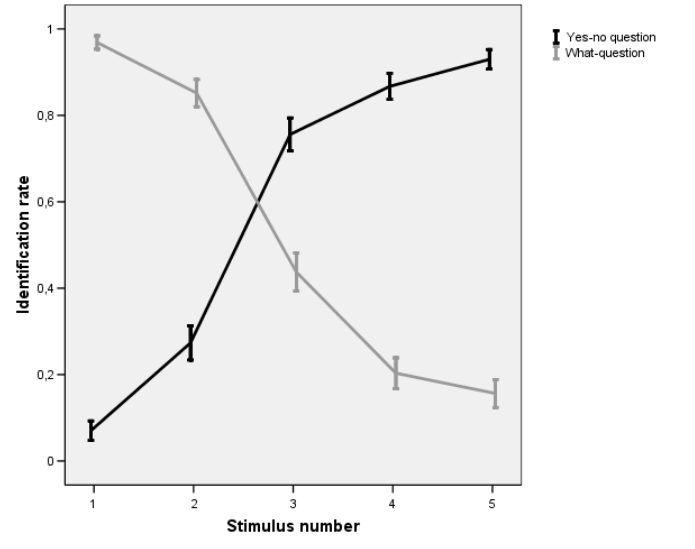
Figure 4. Identification functions for the continua created from yes-no question and what-question base stimuli. Error bars represent the standard error of the